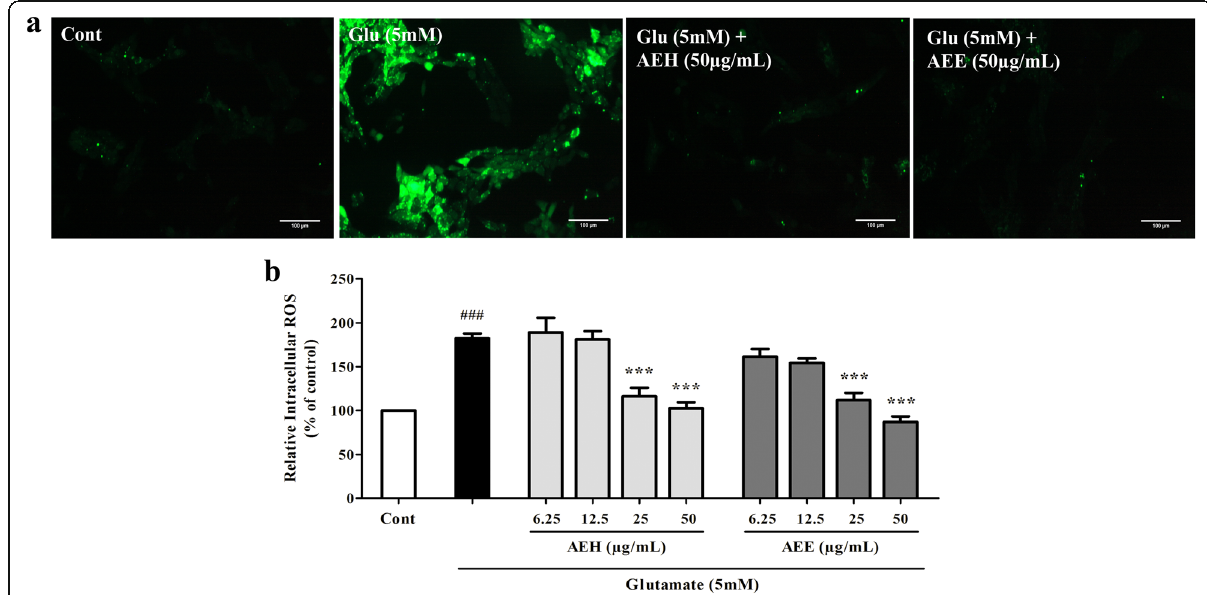
Fig. 5 Effect of AE leaf extracts on glutamate-induced ROS accumulation in HT22 cells. ( a ) Representative confocal micrographs of DCF-derived fluorescence in untreated HT22 cells (control), or cells exposed to 5 mM glutamate alone or glutamate combined with either AEH or AEE at 50 μ g/mL for 14 h. ( b ) Relative intracellular ROS levels of HT22 cells treated with 5 mM glutamate alone or with different concentrations of either AEH or AEE for 14 h, determined using a microplate reader. Data are expressed as the means ± SEM, ### P <0.001 vs. control; ***P <0.001 vs. glutamate